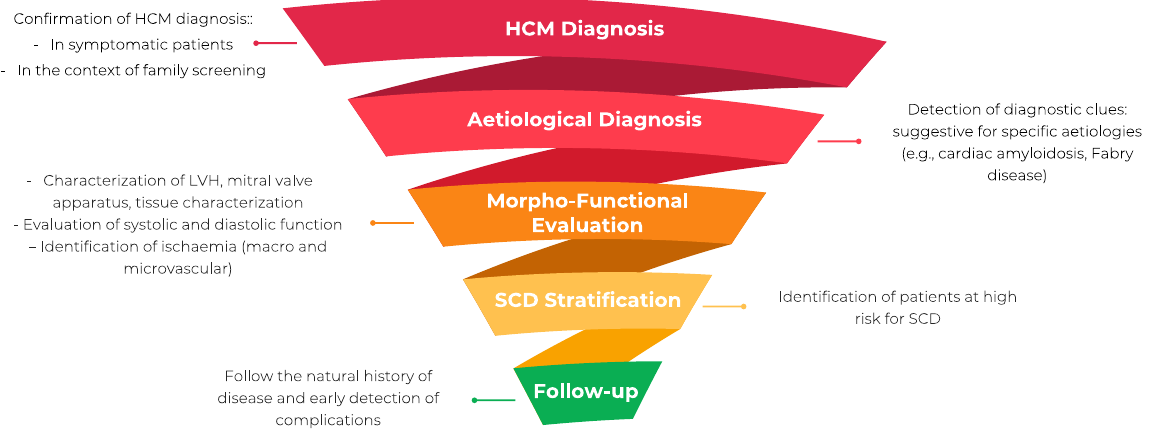
Figure 1. The role of multimodality imaging in hypertrophic cardiomyopathy. LVH, left ventricular hypertrophy; HCM, hypertrophic cardiomyopathy; SCD, sudden cardiac death.